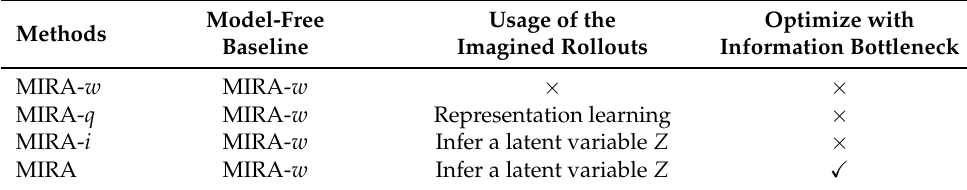
Table 4. Comparison of ablation versions of the proposed method.